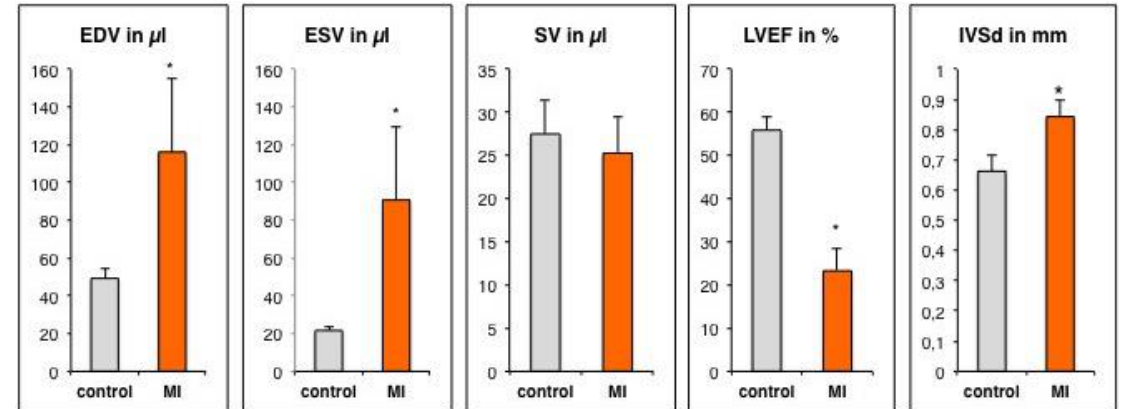
Figure 4. Functional and morphological parameters obtained from cardiac magnetic resonance (CMR) imaging. EDV: enddiastolic volume, ESV: endsystolic volume, SV: stroke volume, LVEF: left ventricular ejection fraction, IVSd: diastolic interventricular wallthickness. Data are presented as mean with SD. * p < 0.05 compared to control group. EDV: end-diastolic volume; ESV: end-systolic volume; SV: stroke volume (EDV-ESV); LVEF: left ventricular ejection fraction (EDV-ESV / EDV*100%); IVSd (diastolic interventricular septal